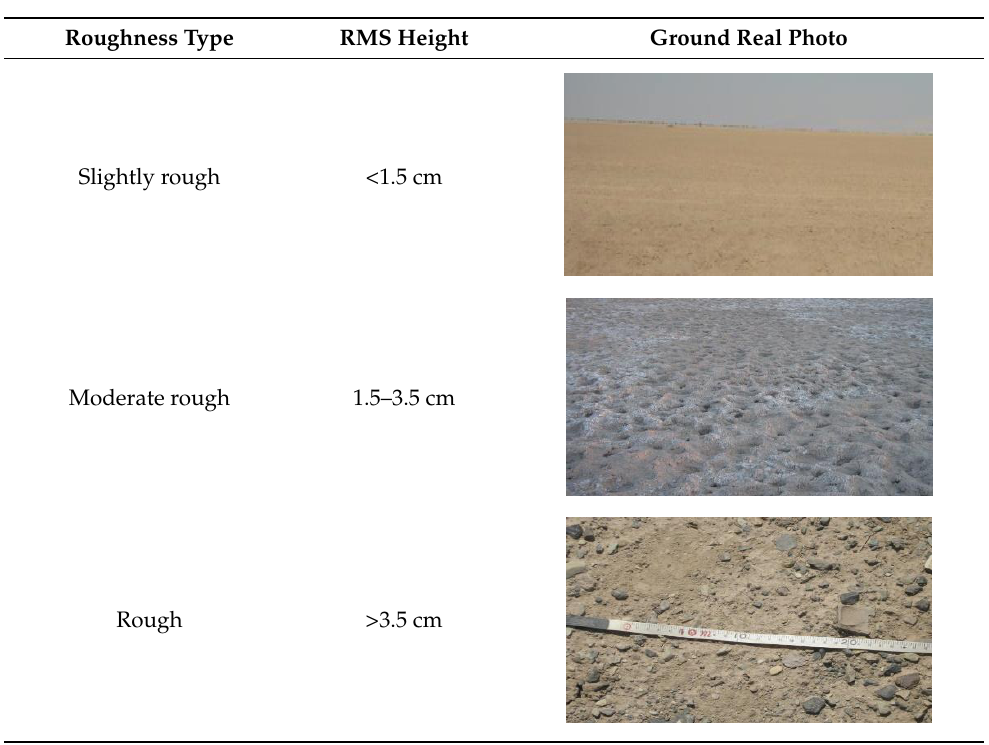
Figure 2. Profile line (2.5 m) of surface roughness modeling with photogrammetry technique in GIS. Table 3. The classification of the roughness type in the study area with a real ground photo of the land.